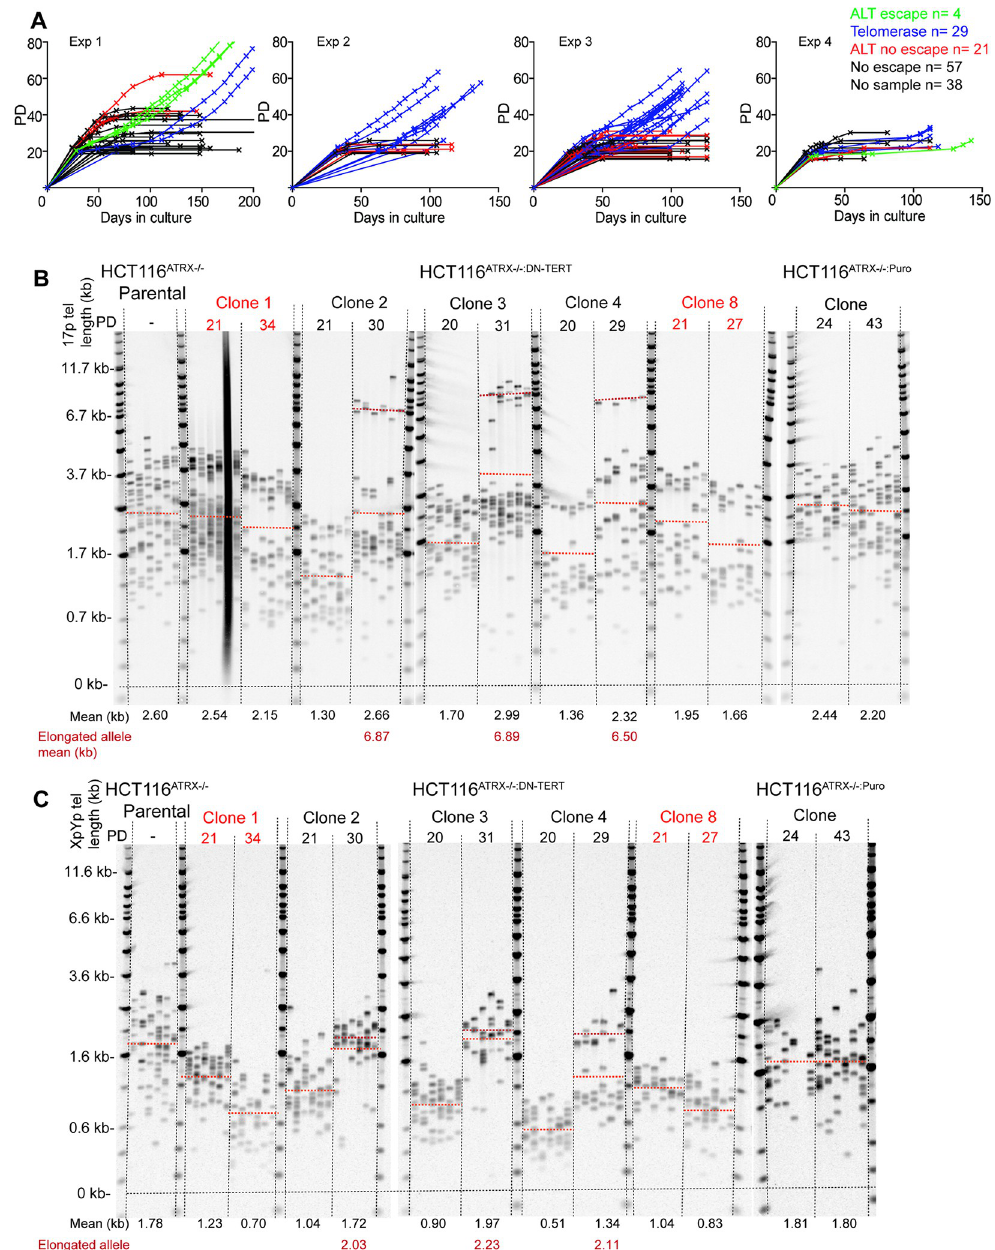
Fig 2. ALT-like initiation in the absence of ATRX in HCT116 epithelial cancer cells undergoing a telomere-driven “crisis”. (A) Growth curves displaying PDs versus days in culture for the 149 HCT116 ATRX-/0:DN-hTERT single cell clones picked across four DN-hTERT transfections represented by the four separate panels; green clones that presented ALT-like telomere elongation; blue clones are telomerase-positive escapees; red clones showed ALT-like characteristics, but did not survive; and black clones are clones that did not survive. STELA profiles at the (B) 17p and (C) XpYp chromosome ends for the HCT116 ATRX-/o parental; HCT116 ATRX-/o:DN-hTERT clones 1 and 8 that did not survive and clones 2, 3 and 4 that exhibited an ALT-like elongation event; and HCT116 ATRX-/o:Puro clone as a transfection control with the PD indicated across the top and the mean telomere length alongside the elongated allele mean in kb shown across the bottom; also represented as orange and red dotted lines, respectively, on the